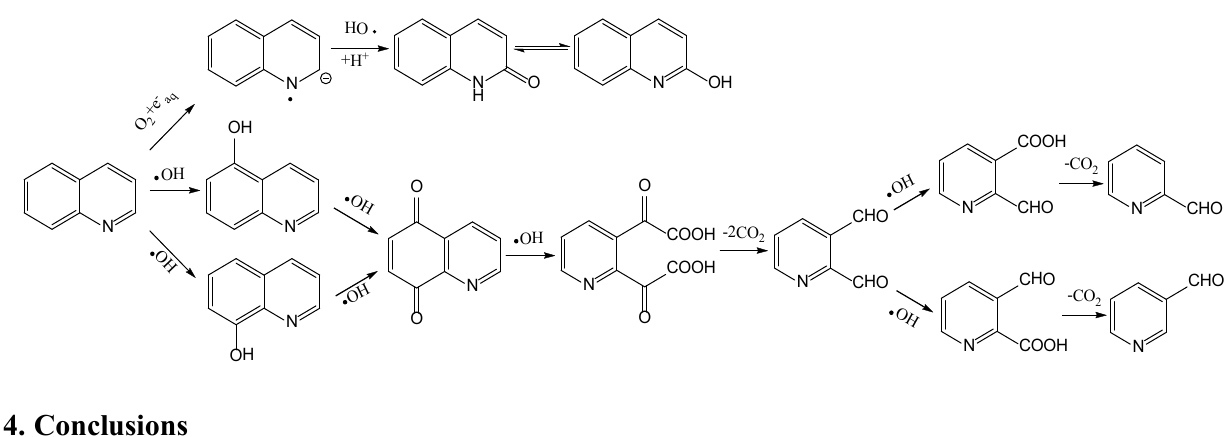
Figure 12. Proposed pathways for the photocatalytic degradation of